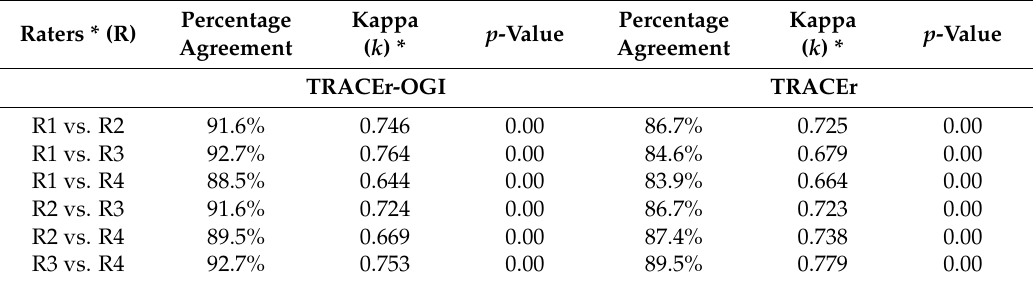
Table 10. The percentage agreement among raters for